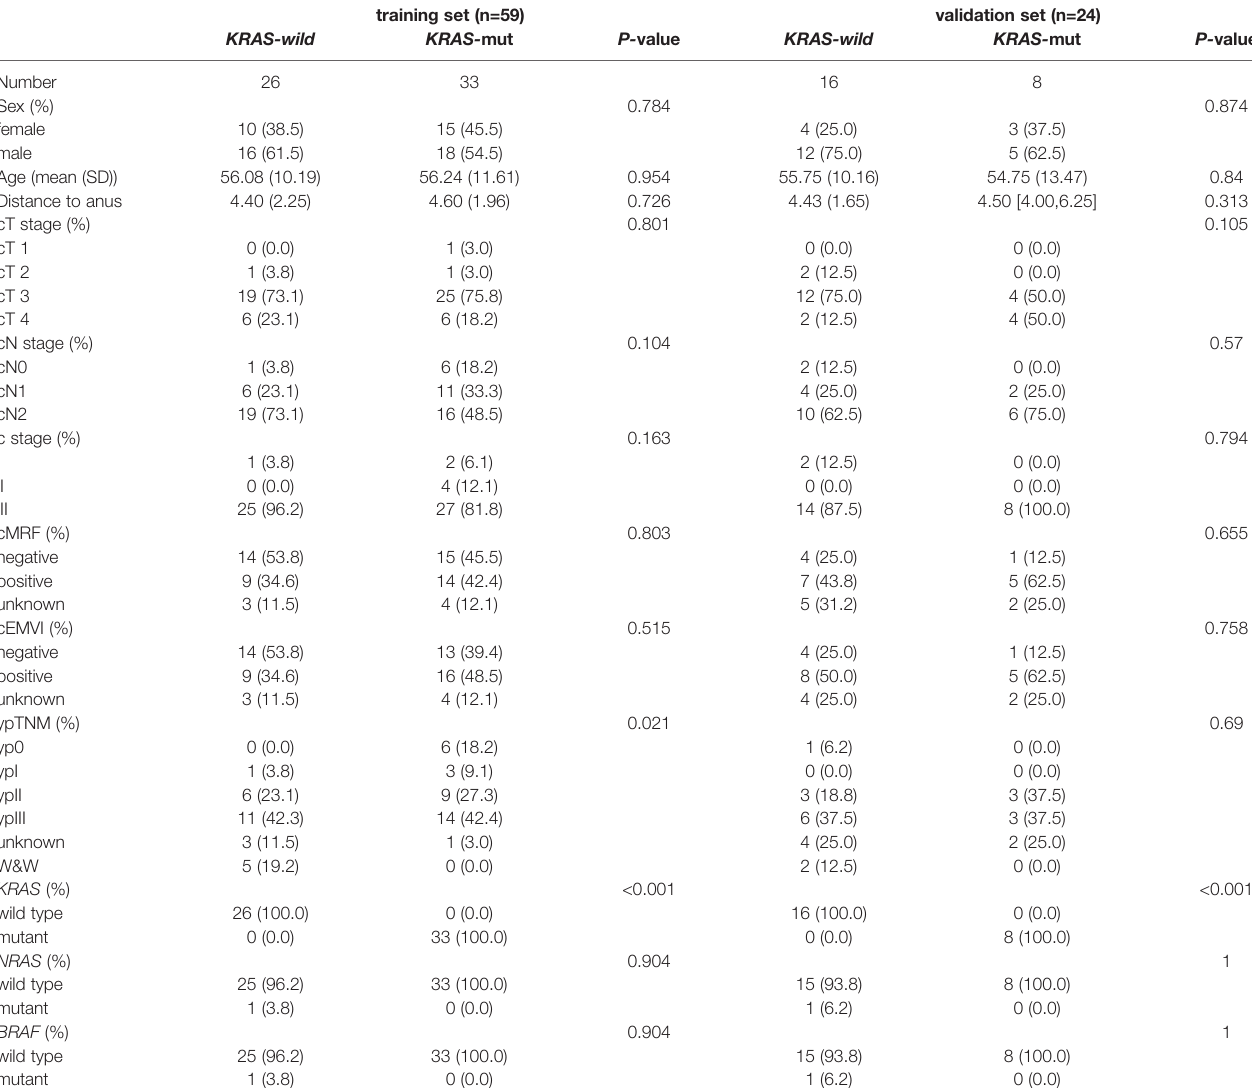
TABLE 4 | Characteristics of patients in the training set and validation